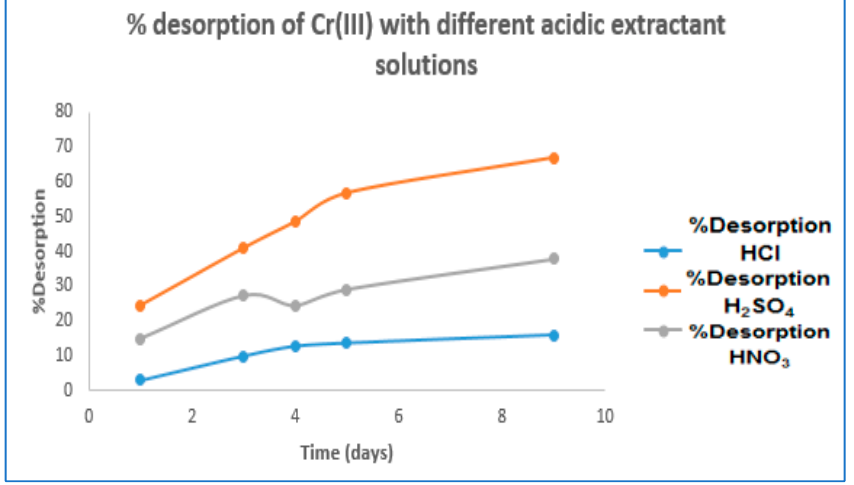
Figure 2. Percentage desorption of Cr(III) with different acidic extractant solutions.